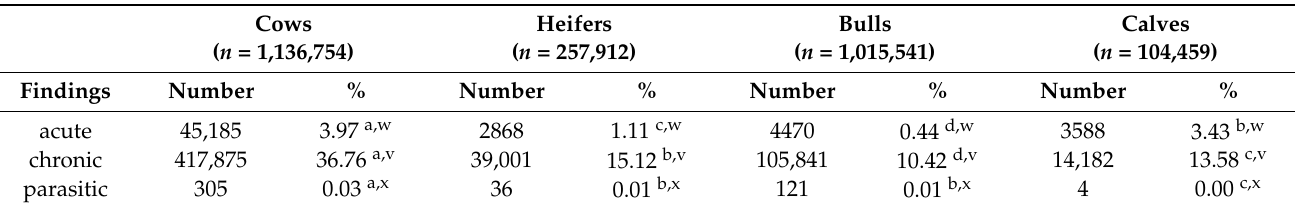
Table 4. Comparison of the occurrence of pathological findings in the kidneys in cows, heifers, bulls and calves slaughtered in slaughterhouses.